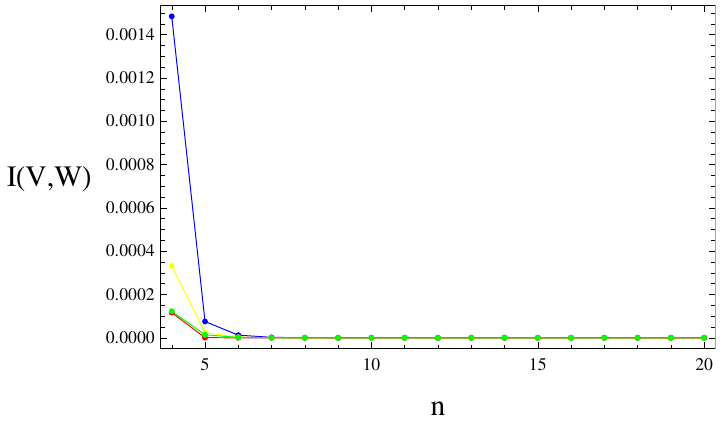
Figure 21 . The mutual information of gauge (cid:12)elds coupling with matter between two squares of equal sizes separated by a distance equal to the square size for algebra B (blue curve), ~ B (yellow curve), B ~ A (red curve) and B (cid:25) (green curve). We take m = 1 in this (cid:12)gure. In the limit n ! 1 , the mutual information for all four algebra choices goes to 0 very fast.